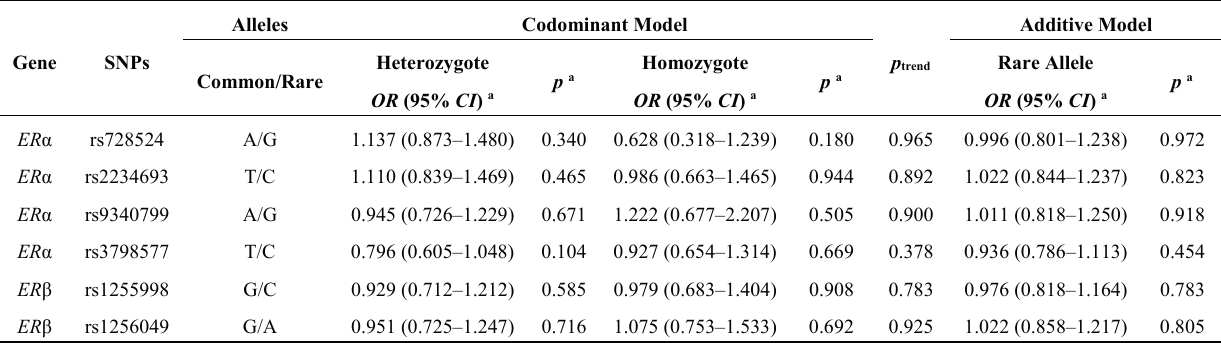
Table 4. Single SNPs in estrogen receptors and association with breast cancer.